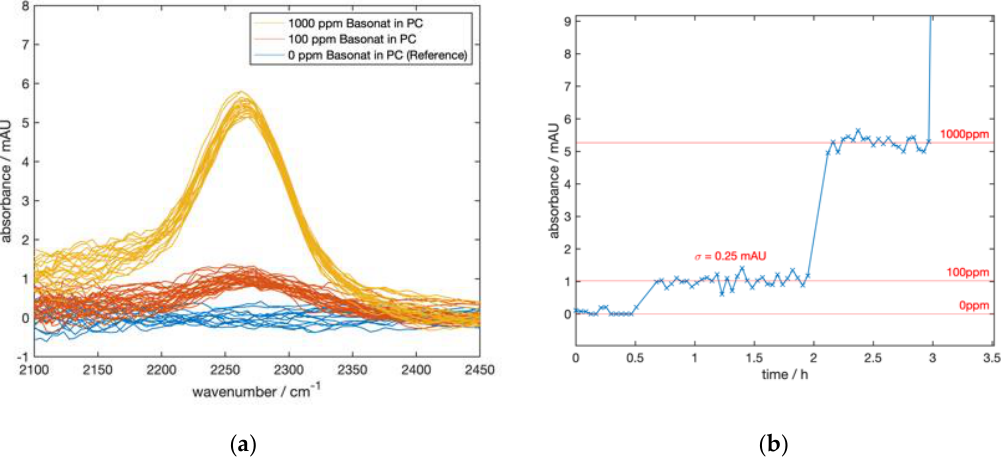
Figure 2. ( a ): FPI spectra of Basonat solutions in propylene carbonate (PC) using the planar ATR setup. Each spectrum was recorded within 150 s and smoothed with a moving average filter. ( b ) Concentration steps derived from ( a ) by a linear fit procedure based on an averaged 10,000 ppm (m/m) spectrum. The total measurement duration was around 5 h (including a 10,000 ppm (m/m) solution not shown here).